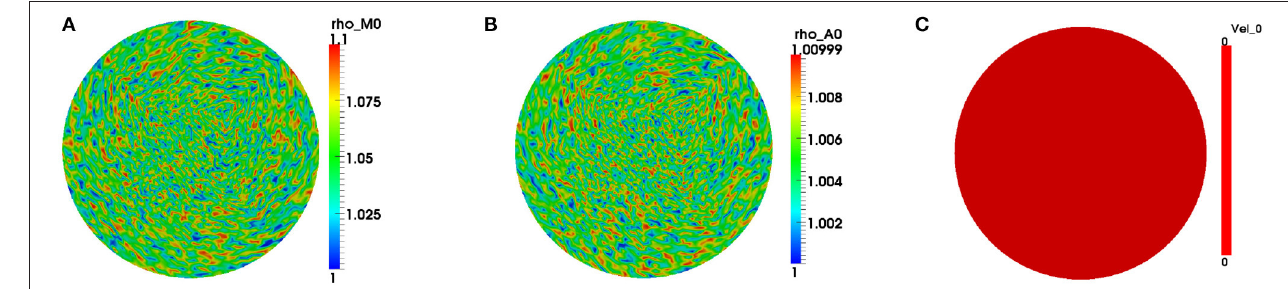
FIGURE 1 | Initial conditions for the variables. We begin simulations by considering initial concentrations of the variables, respectively, as random perturbations about (A) ρ